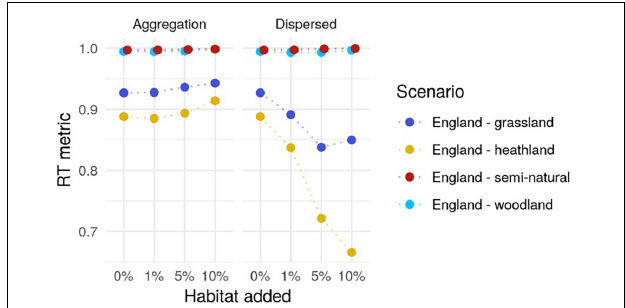
FIGURE 3 | The rule of thumb (RT) metric for each of the simulated landscapes at the England scale. The points are the metric calculated for each scenario, with dashed lines connecting the baseline and three levels of habitat